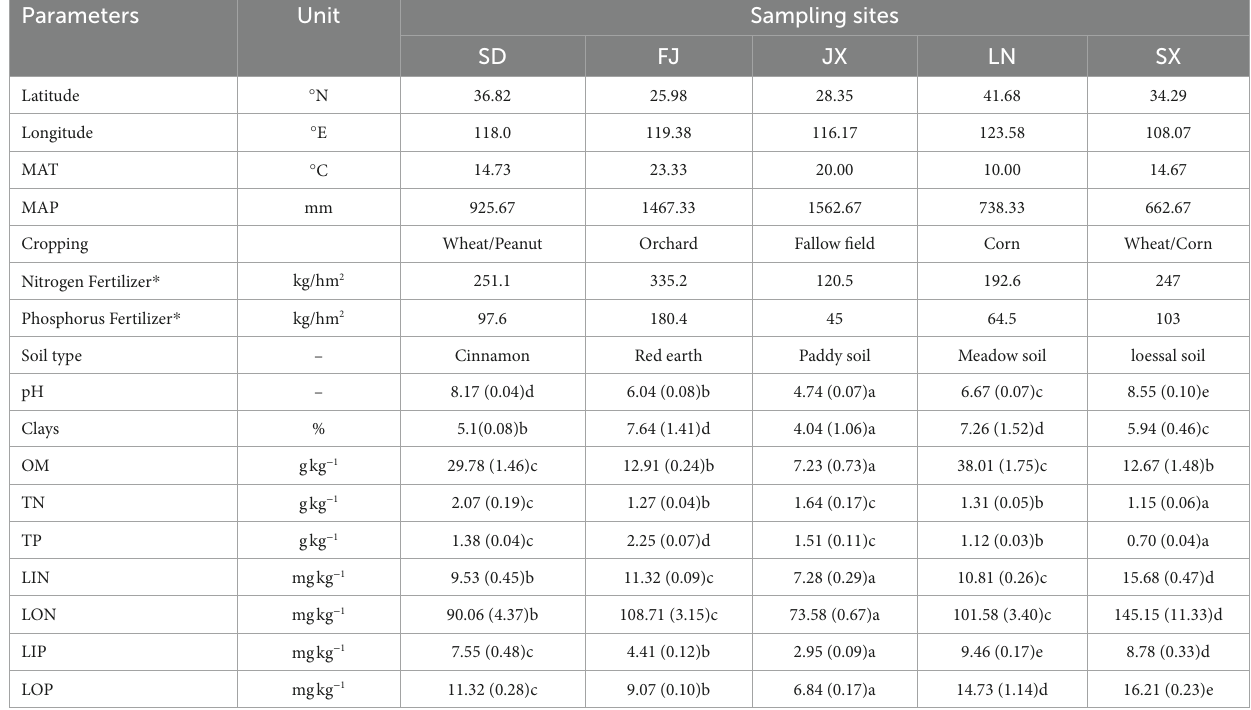
TABLE 1 Location of sampling, weather conditions, cropping, fertilization, and soil characteristics [listed as mean ± standard error ( n = 3)].